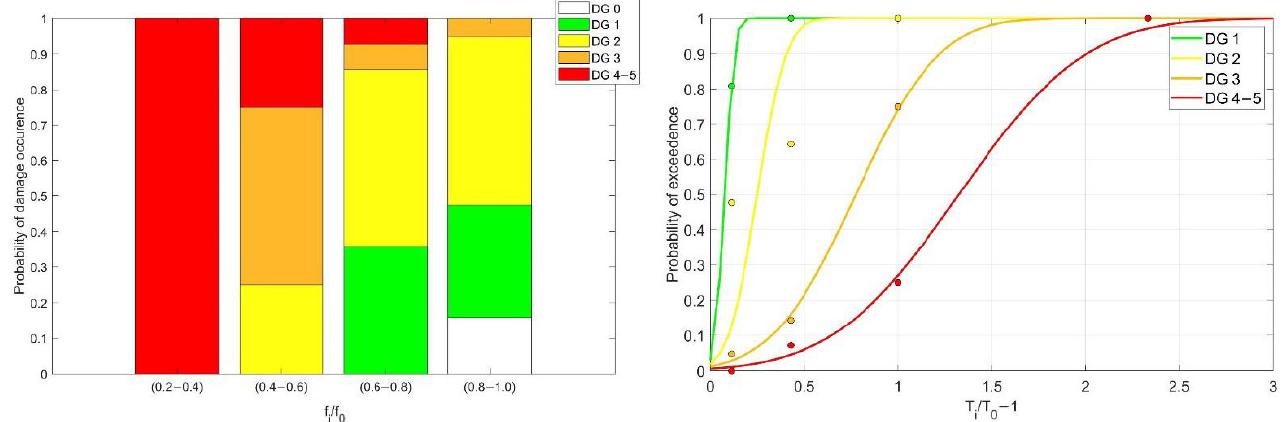
Figure 2. Histograms and damage functions based on the empirical data available in Goulet et al. (2015).